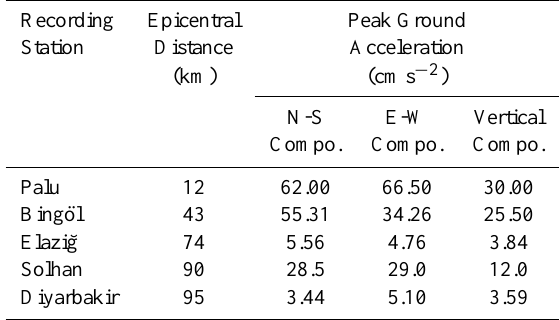
Table 1. Peak acceleration values (ED,